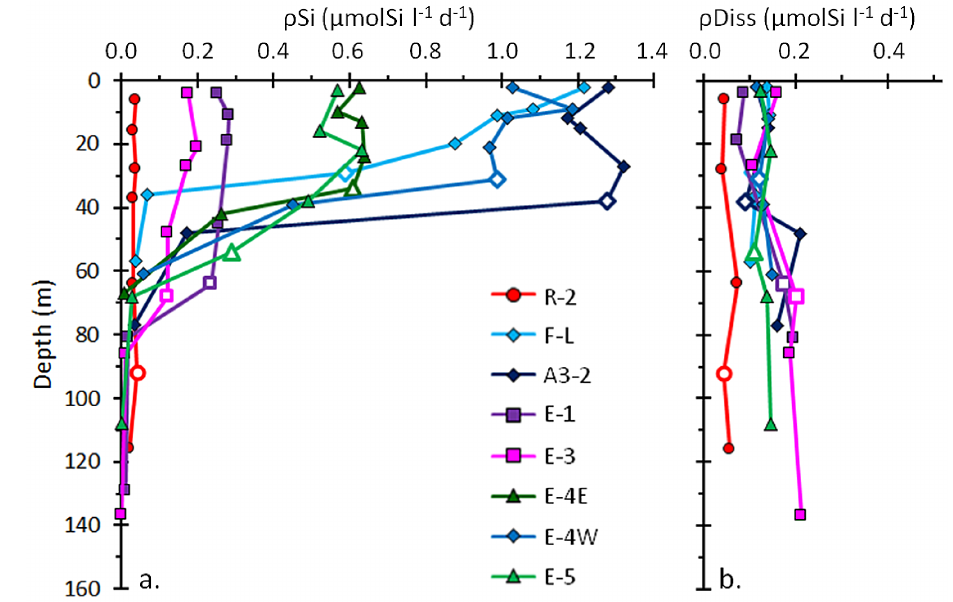
Figure 4. Vertical distribution of Si uptake ( ρ Si, a ) and biogenic silica dissolution ( ρ Diss, b ) at the KEOPS-2 stations. Open symbols represent the depth at the bottom of the euphotic layer (1% of photosynthetically active radiation) for each station. Table 2. Biogenic silica concentration ( R [BSi]), Si-uptake ( R ρ Si), biogenic silica dissolution ( R ρ Diss), silica net production ( R ρ Net) integrated over the euphotic layer (1% of surface Photosynthetically Active Radiation), and integrated specific rates of Si-uptake and silica dissolution (calculated as R VSi= R ρ Si/ R [BSi] and R Diss= R ρ Diss/ R [BSi],